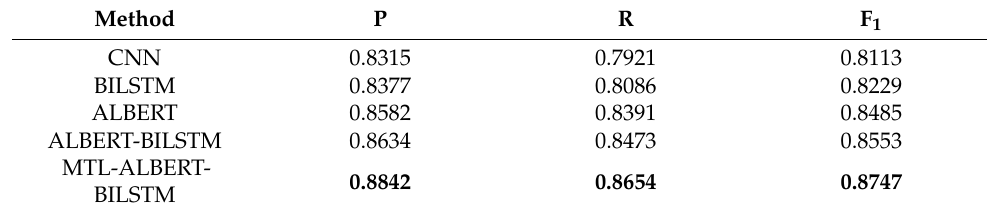
Table 3. Results of intent classification on different model.